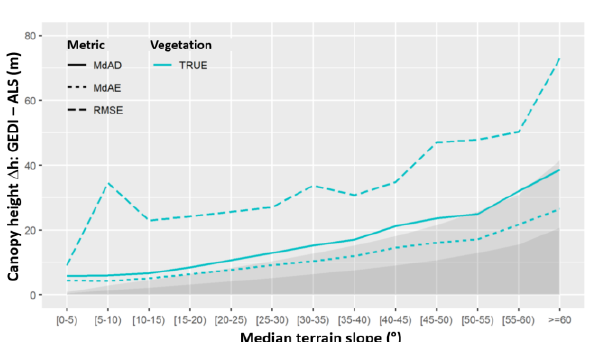
Figure 13. Accuracy metrics of canopy heights with grey areas representing hypothetical vertical component of the 1 σ and 2 σ horizontal misplacement at each slope category.